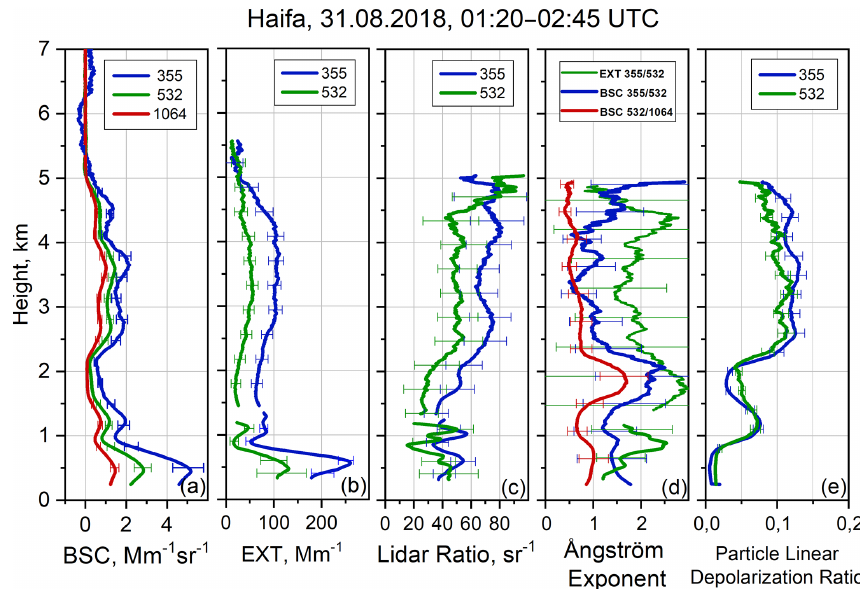
Figure 4. Profiles of the lidar optical properties particle backscatter coefficient (BSC), particle extinction coefficient (EXT), lidar ratio (LR), Ångström exponent, and particle linear depolarization ratio (PLDR) of the case study measured at Haifa on 31 August 2018. Near-range profiles are adapted for EXT, LR and the extinction-related Ångström exponent. The height range is starting above the measurement